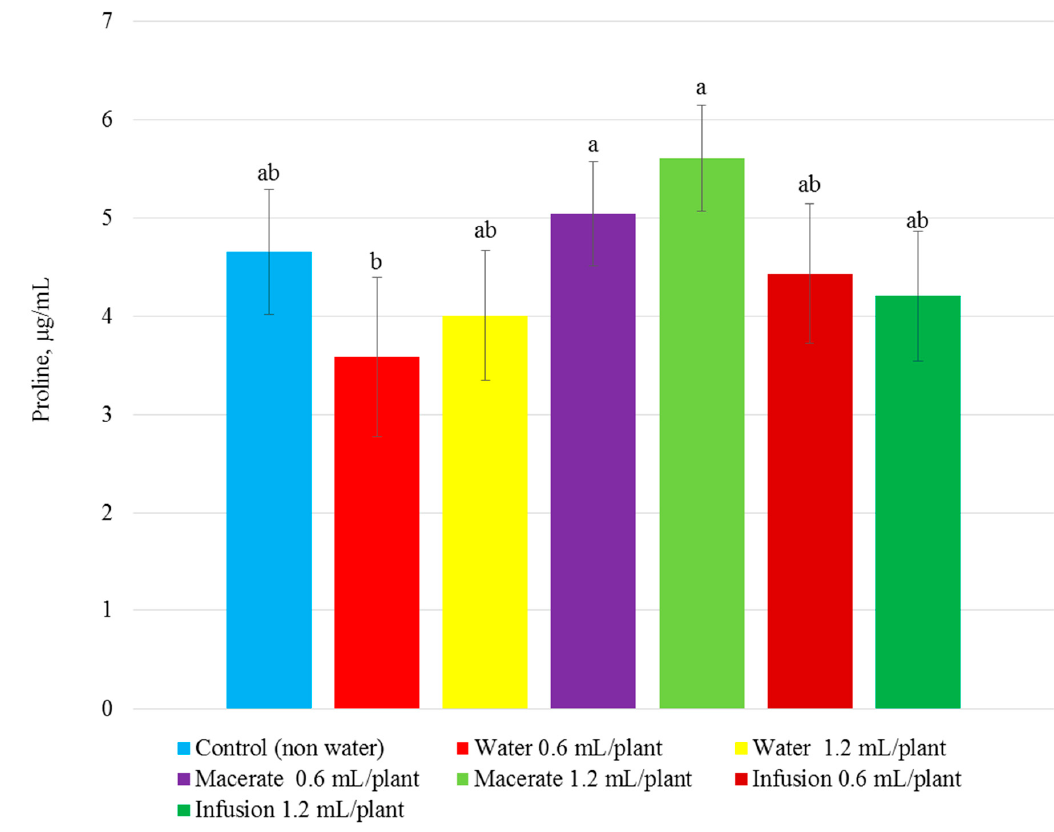
Figure 3. Proline concentration in potato leaves treated with extracts form Artemisia vulgaris L. (average of three independent experiments and SD). Values followed by different small letters are significantly different at p < 0.05.